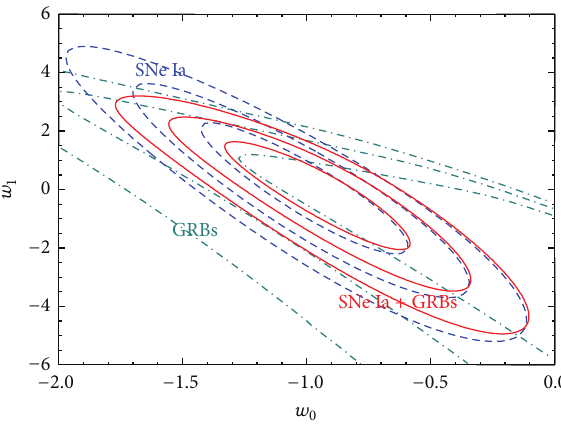
Figure 5: Constraints on Ω 𝑚 and 𝑤 0 from 1𝜎 to 3𝜎 confidence regions with dark energy whose equation state is constant. The contours are derived from GRBs (dark cyan dash-dotted lines), SNe Ia (blue dashed lines), and SNe Ia + GRBs (red solid lines), respectively.